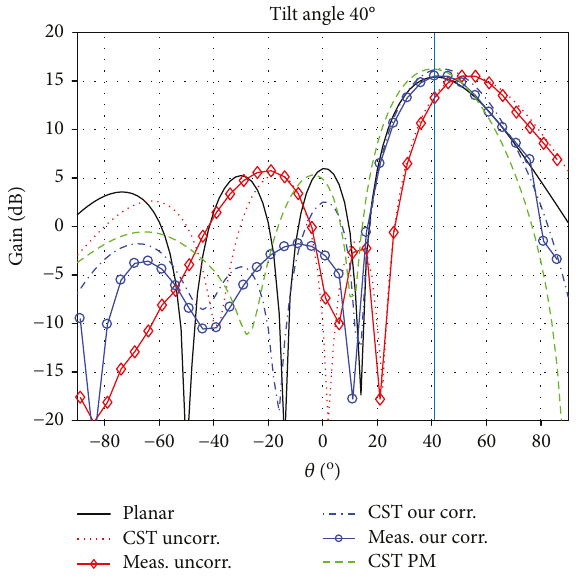
Figure 7: Simulated and measured 4 × 4 antenna gain: planar, uncorrected, corrected with our approach, and corrected with the projection method patterns on the yz -plane for θ